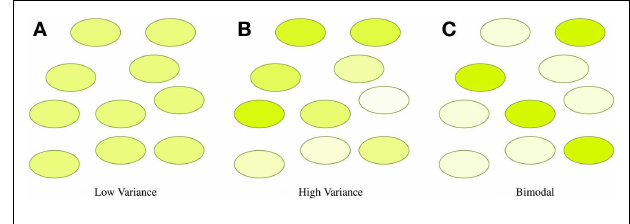
FIGURE 4 |Assays that measure population means or totals cannot distinguish between even radically different distributions of expression . For example, the tight (A) , broad (B) , and bimodal (C) distributions illustrated above all have the same mean and total